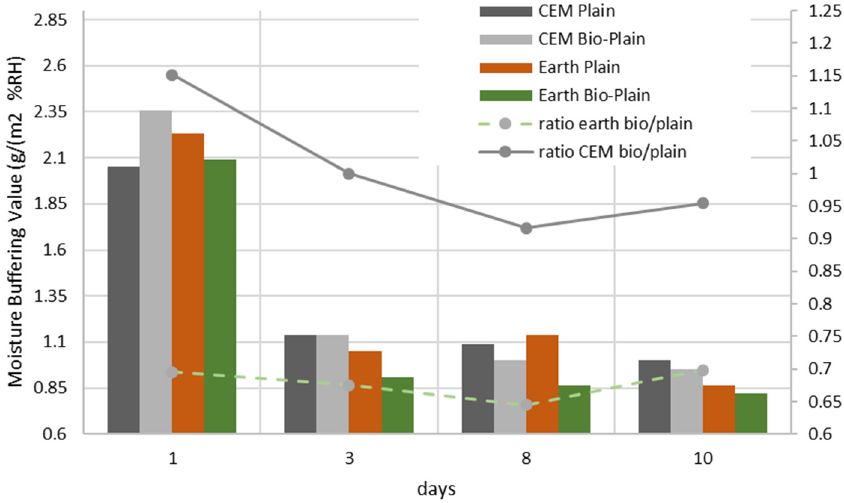
Figure 15. MBV for bio and non-bio earth and cement mortars after 1 month.